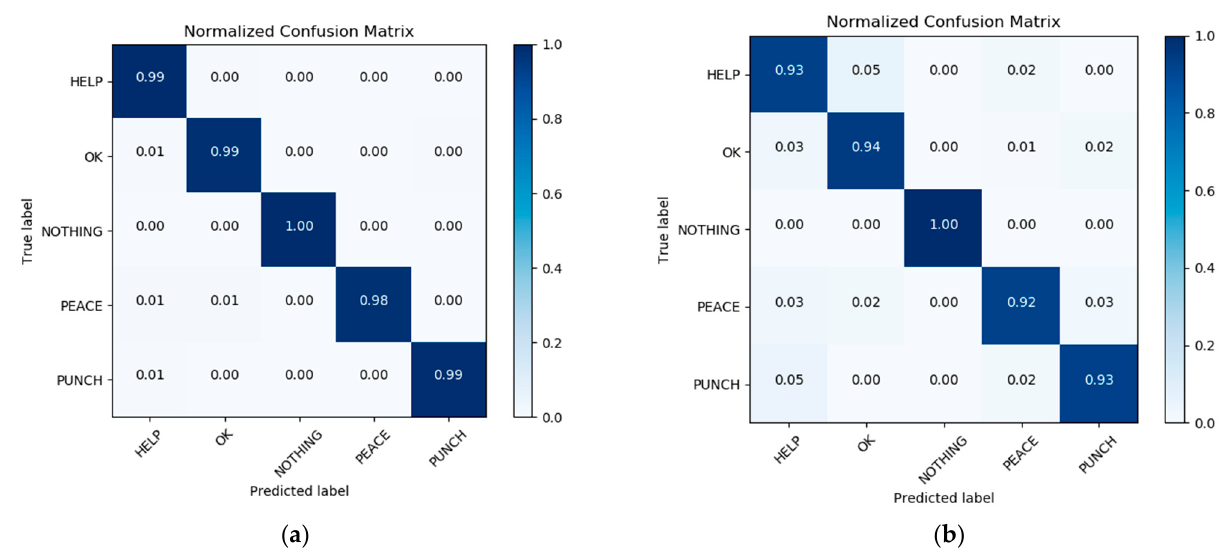
Figure 16. Standard matrix with predicted labels on X -axis and true labels on the Y -axis tested on hand gesture training set ( a ) and in testing dataset ( b ).